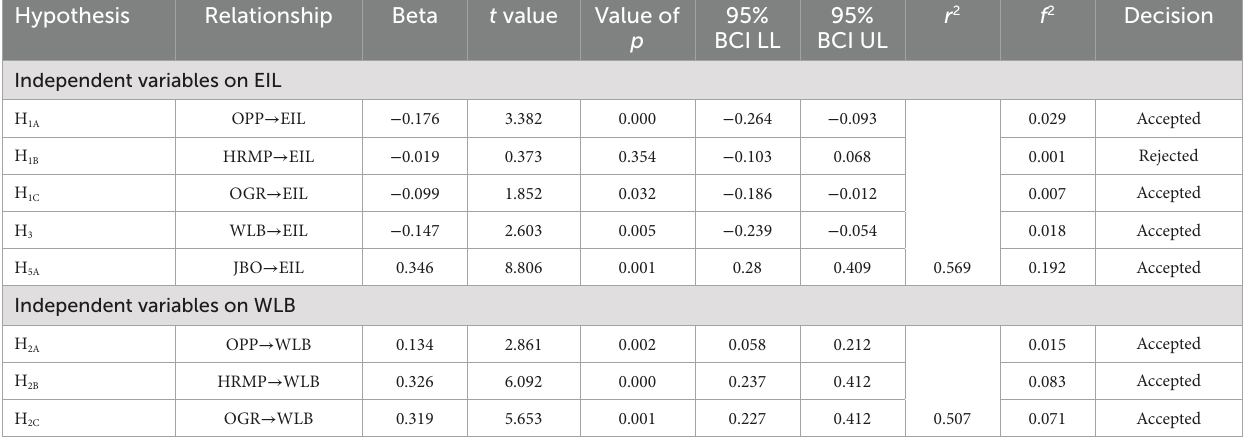
TABLE 4 Hypothesis testing direct